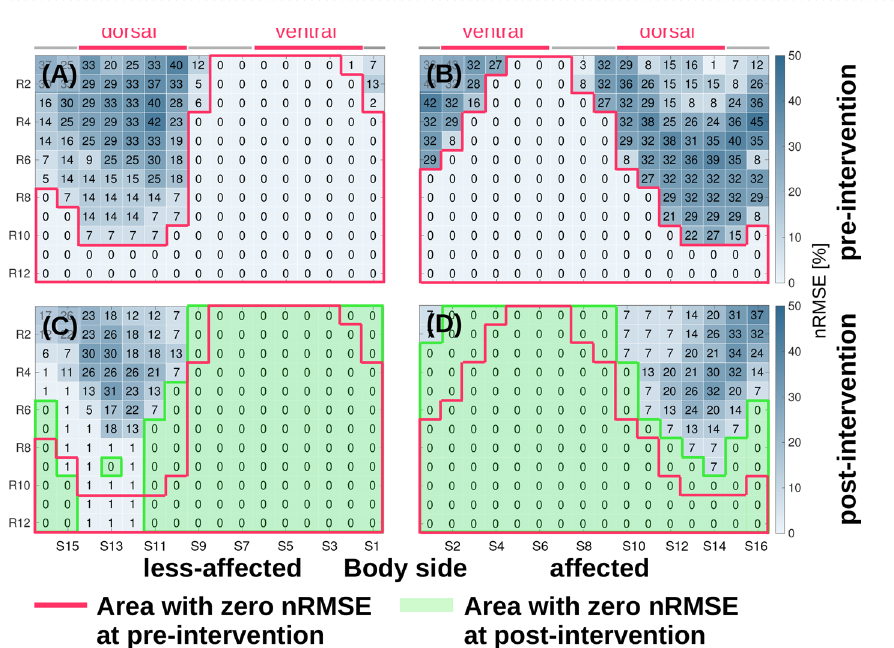
Figure 7. nRMSE maps for marker stride duration of a hemiparetic patient (ID8, left side affected). Walking speed was 0.3 m/s and 0.5 m/s respectively in pre- and post-intervention data. ( A , B ) Less-affected and affected upper leg for pre-intervention. ( C , D ) Less-affected and affected upper leg for post-intervention. Both body sides show larger error-free areas after the intervention. Ventral sensor positions should be favoured over dorsal